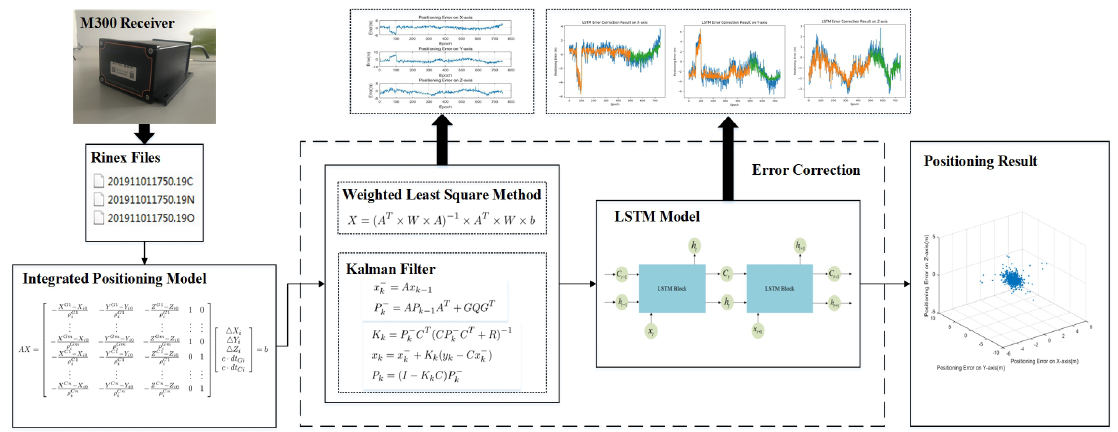
Figure 3. The overall flow of the LSTM-based error correction